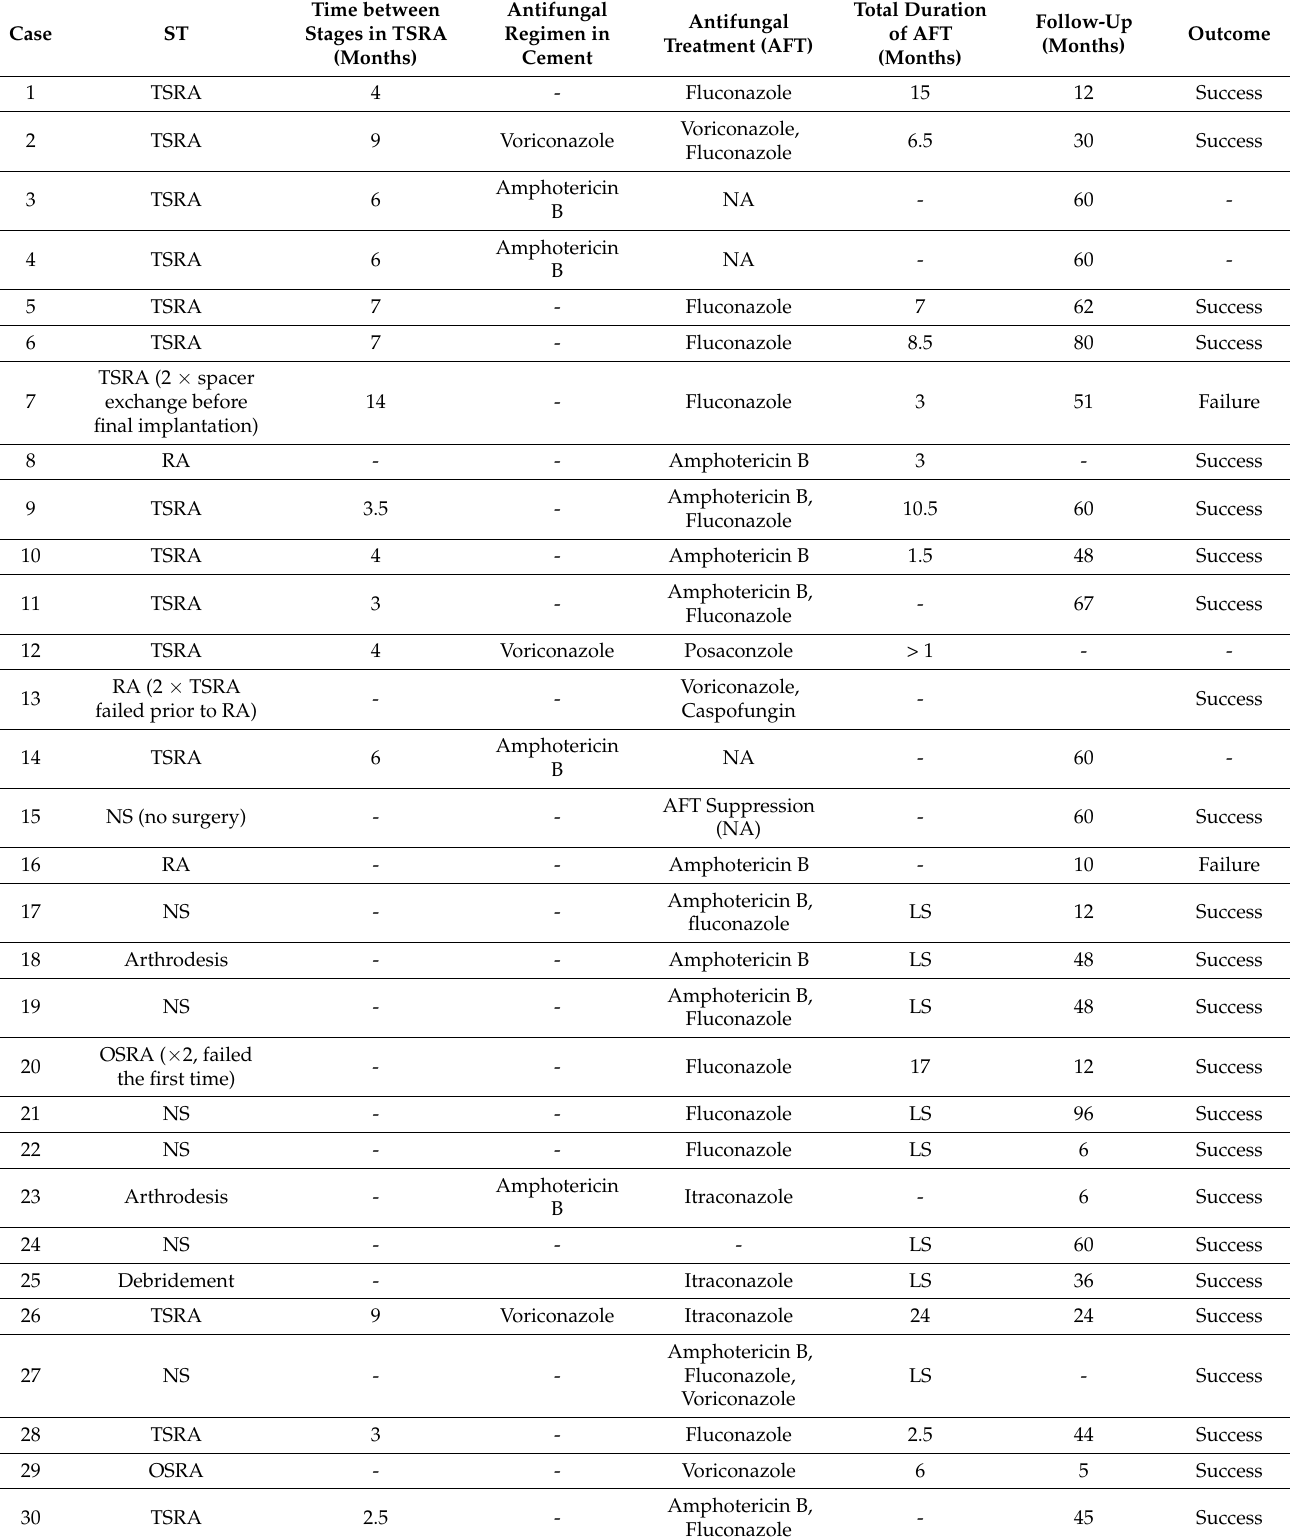
Table 2. Surgical and antifungal treatment, follow-up, and infection outcome of the reported cases. ST: surgical treatment; TSRA: two-stage revision arthroplasty; OSRA: one-stage revision arthroplasty; AFT: antifungal treatment; LS: